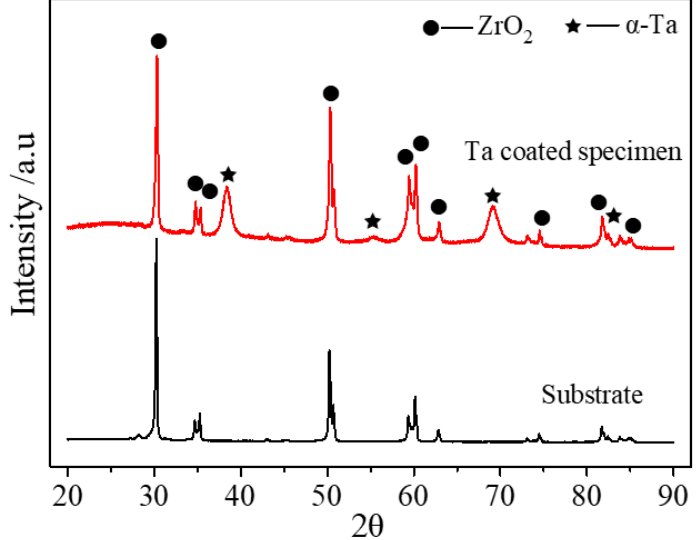
Figure 2. XRD profiles of as-received 3Y-TZP substrate and Ta-coated specimens.